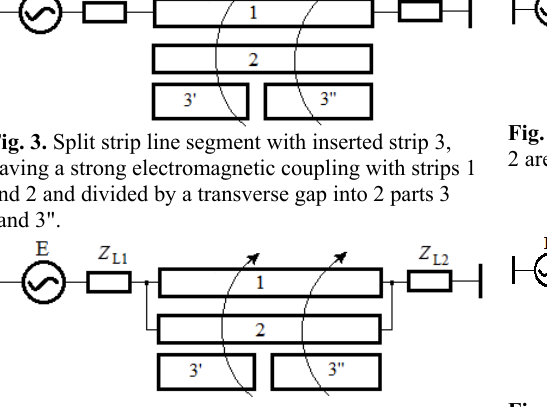
Fig. 5. Split strip line segment in which strips 1 and 2 are connected in parallel and a third strip is inserted and coupled with the 1'st and 2'nd strips and segmented by a transverse gap into 2 parts.